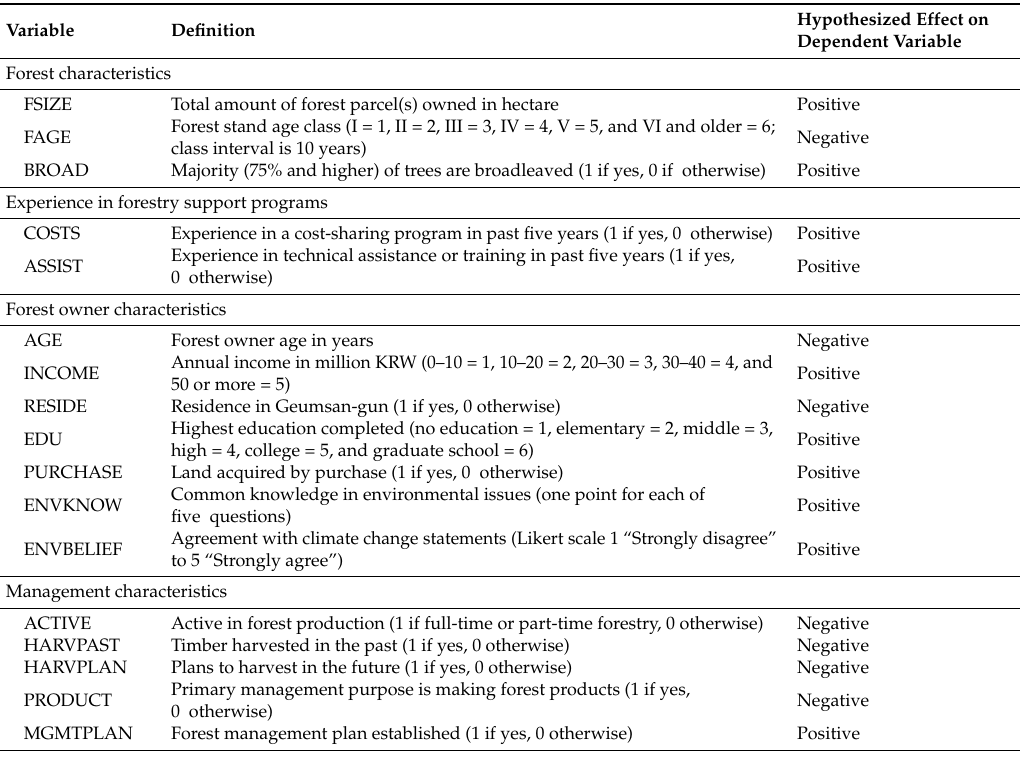
Table 2. Definitions of explanatory